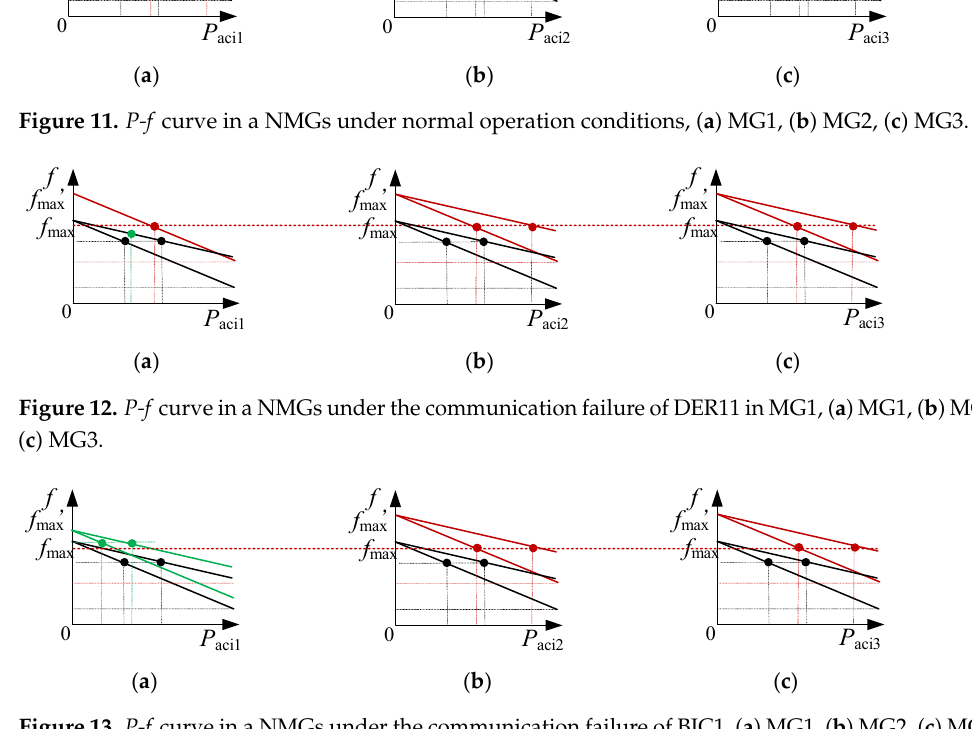
Figure 13. P-f curve in a NMGs under the communication failure of BIC1, ( a ) MG1, ( b ) MG2, ( c ) MG3.